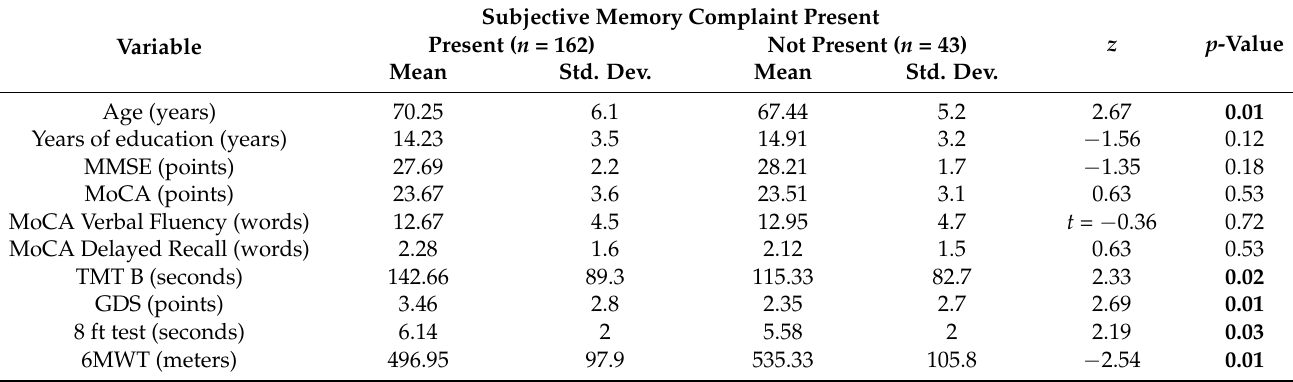
Table 3. Difference in variables measured in the baseline between subgroups with subjective memory complaint (SMC) present vs. non-present after two